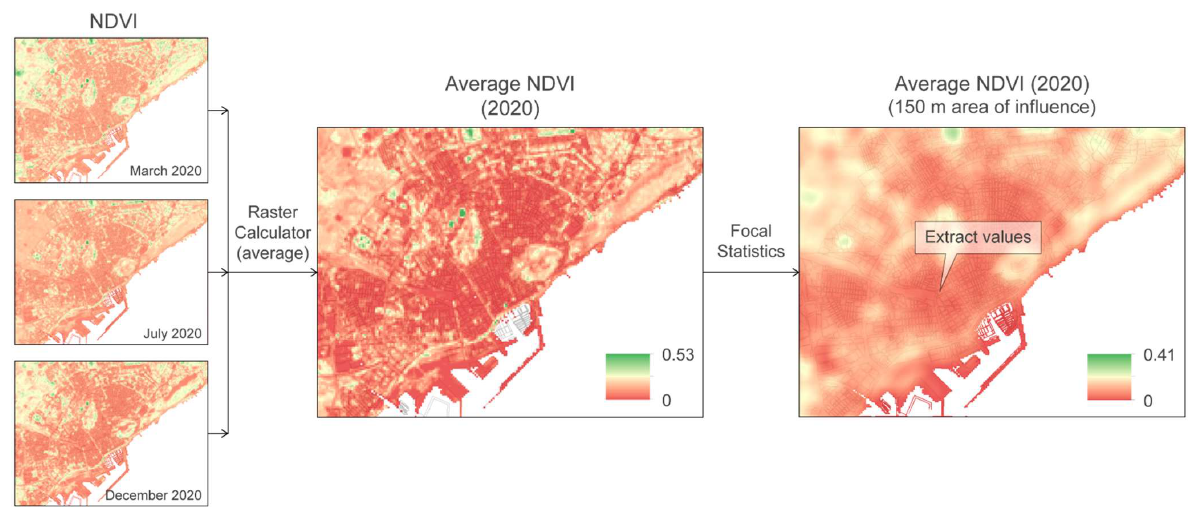
Figure 5. NDVI calculation process (feature D_NDVI_150m ).